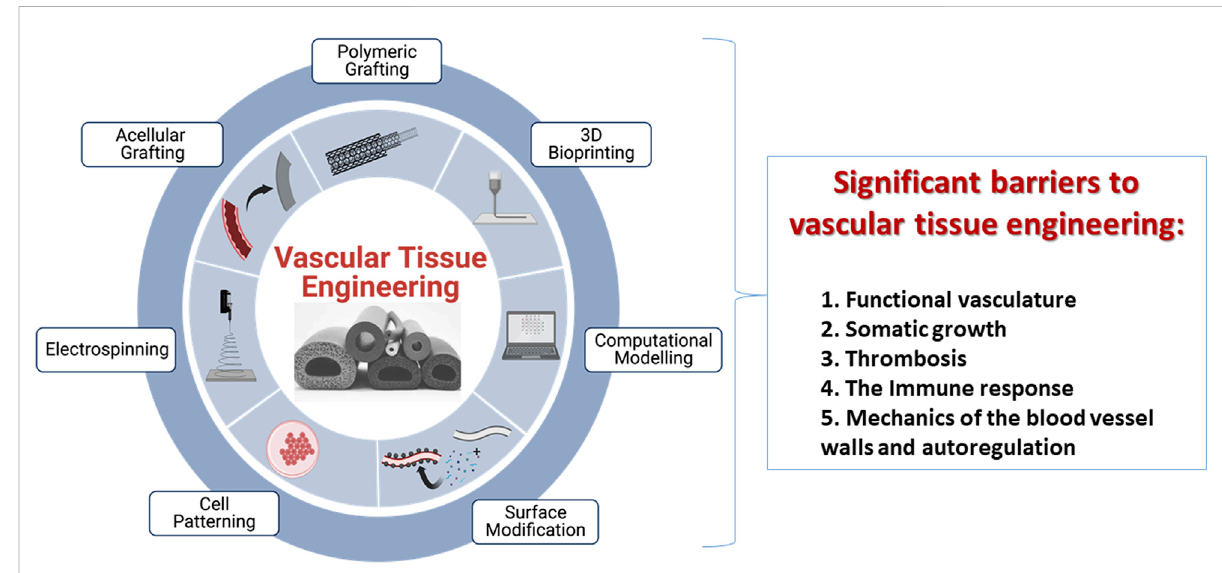
FIGURE 1 An illustration of current techniques, including polymeric grafting, 3D bioprinting, computational modeling, surface modi fi cation, cell patterning, electrospinning, and acellular grafting, used to create tissue-engineered vascular grafts with promising remodeling capabilities and limitations that restrict their viability post-transplantation. These limitations are a lack of functional vasculature, an inability to support somatic growth, detrimental induction of thrombosis post-transplantation, immune responses and biomechanics of the vessel